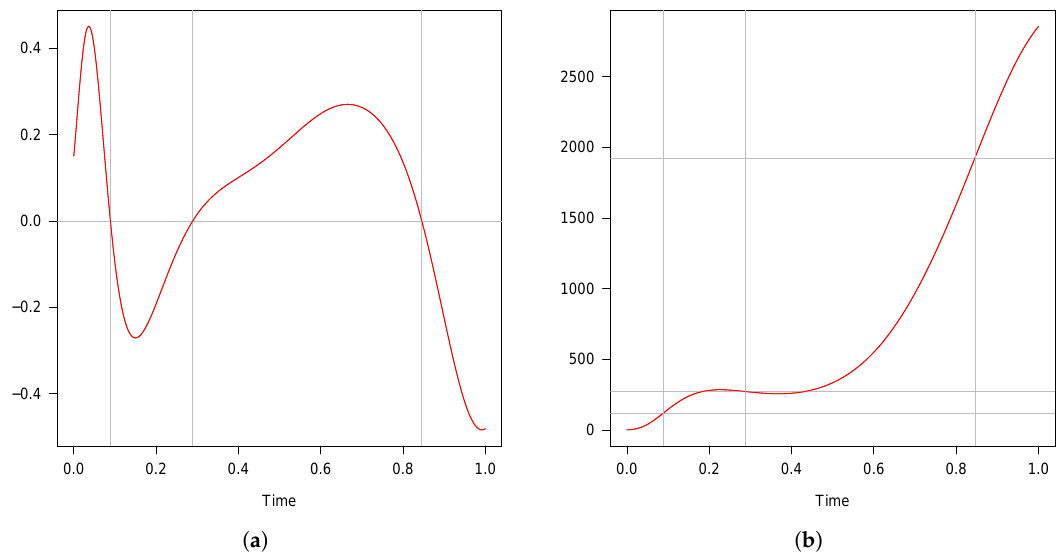
Figure 5. Study of infected: Estimated inflection time instants from ( a ) the second derivative of the estimated mean function and ( b ) the estimated mean function for the multi-sigmoidal Gompertz model. The vertical lines are located on the estimated